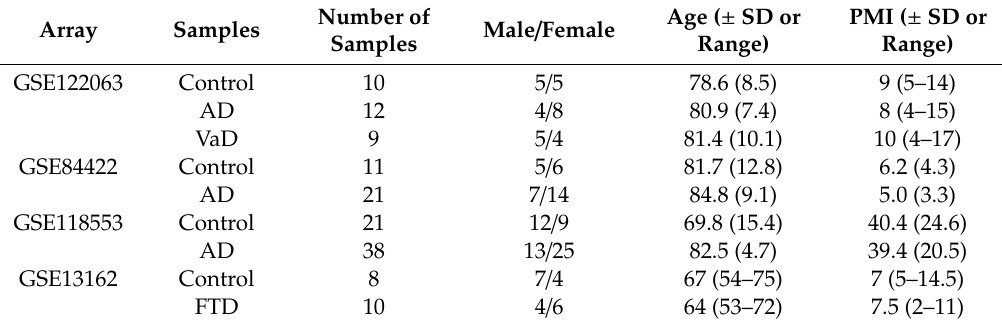
Table 3. Demographical information. PMI, postmortem interval in